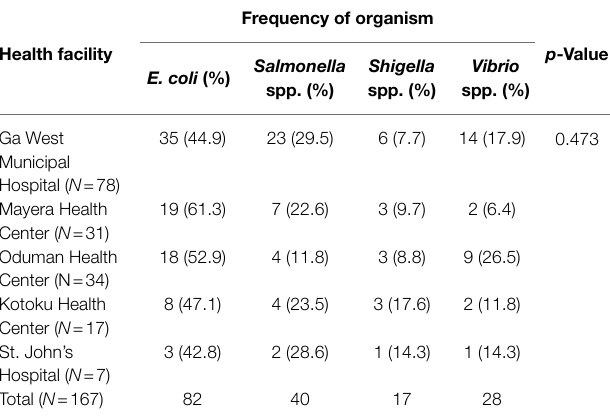
TABLE 2 | Bacteria isolates and serotypes. Variable